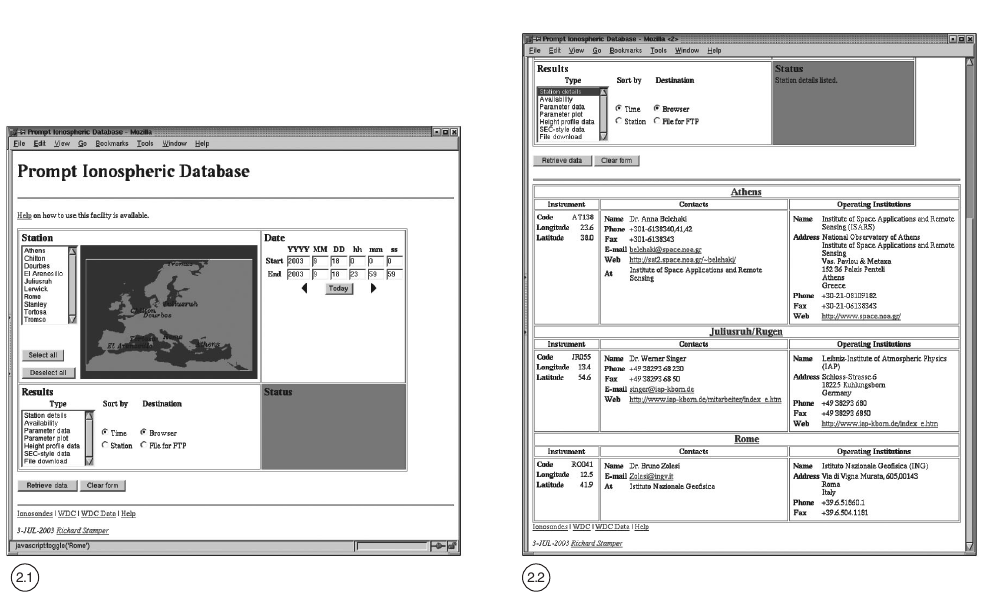
Fig. 2.1. The front page of the Prompt Ionospheric Soundings Database, showing the options for selecting da- ta by station and date, and for selecting the type and mode of delivery of the data product. Fig. 2.2. The details of stations available from Ionospheric Soundings